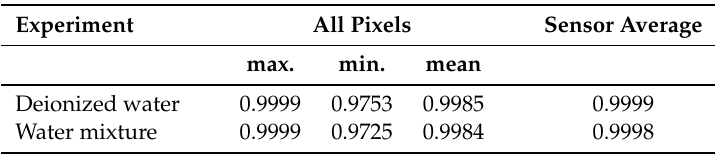
Table 1. Coefficient of